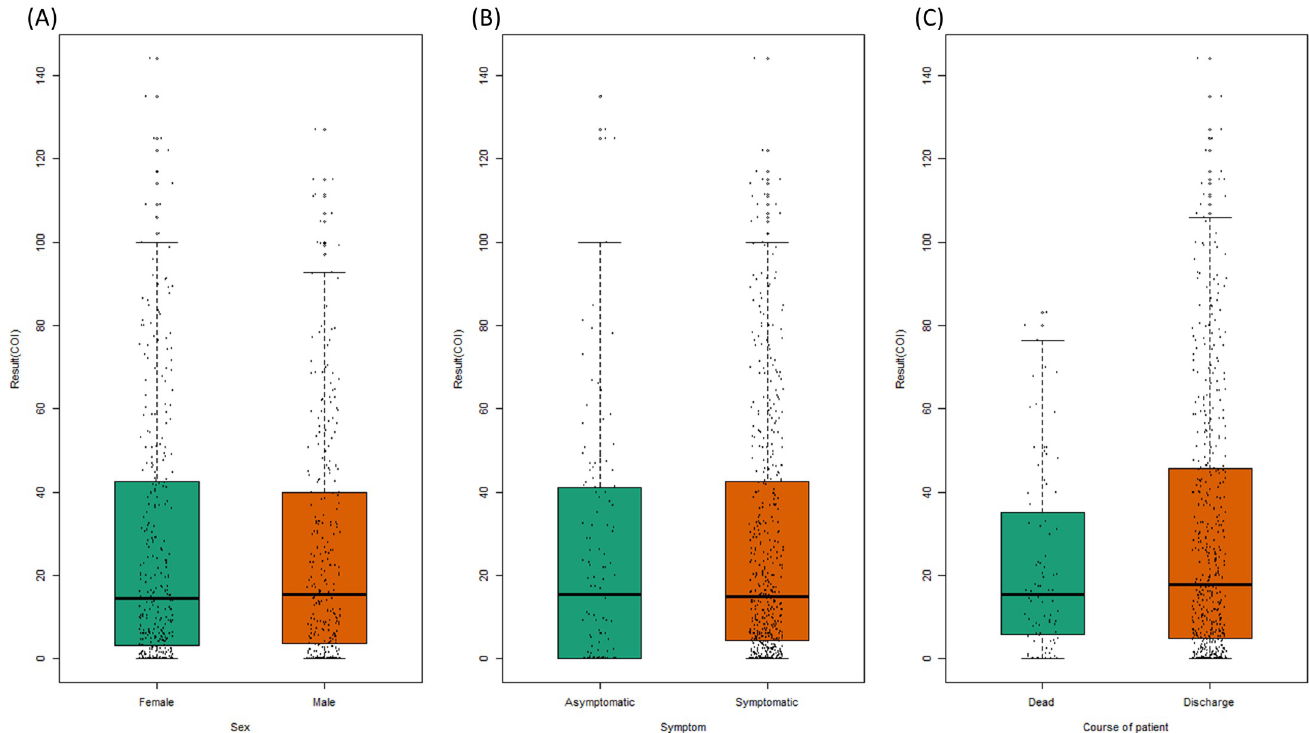
Fig 4. COI of anti-SARS-CoV-2 antibody according to sex (A), presence of symptoms (B) and disease course (C). Data are means with 95% confidence intervals.